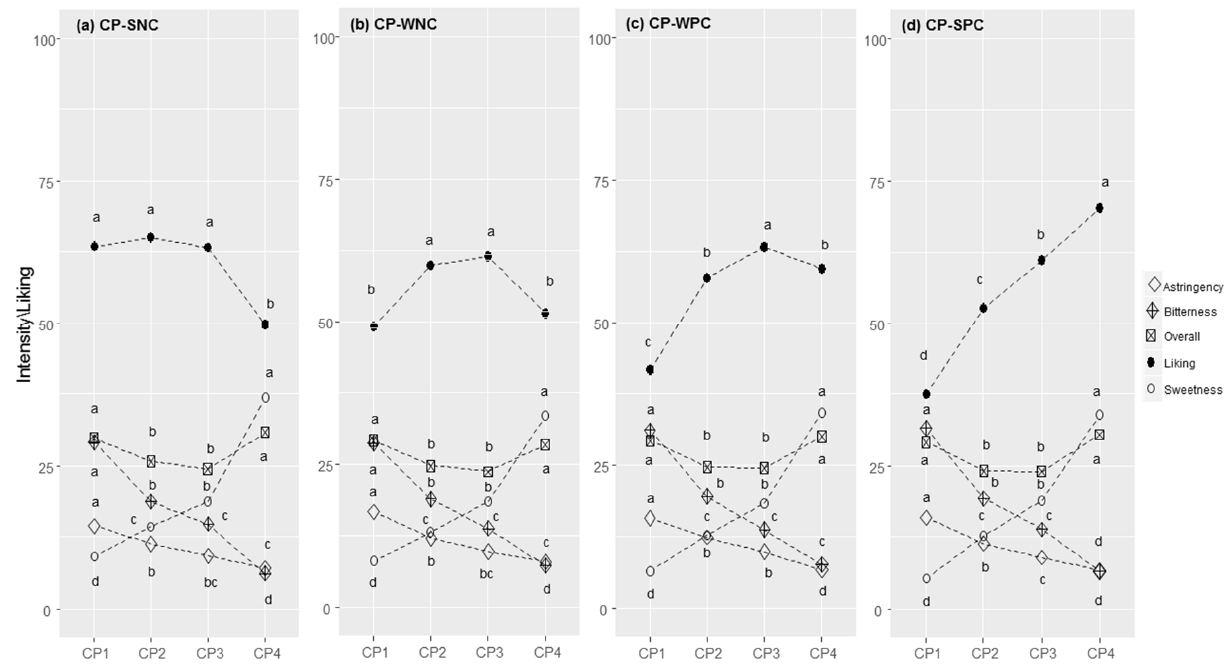
Figure 4. Chocolate Pudding (CP) responses in each cluster (SNC = Strong Negative Correlation ( a ), WNC = Weak Negative Correlation ( b ), WPC = Weak Positive Correlation ( c ), and SPC = Strong Positive Correlation ( d )): perceived intensity (gLM scale) and liking (LAM scale) for samples at increasing concentrations of sucrose (1–4). Within each cluster, different letters indicate significant differences in intensity/liking between concentration levels ( p <